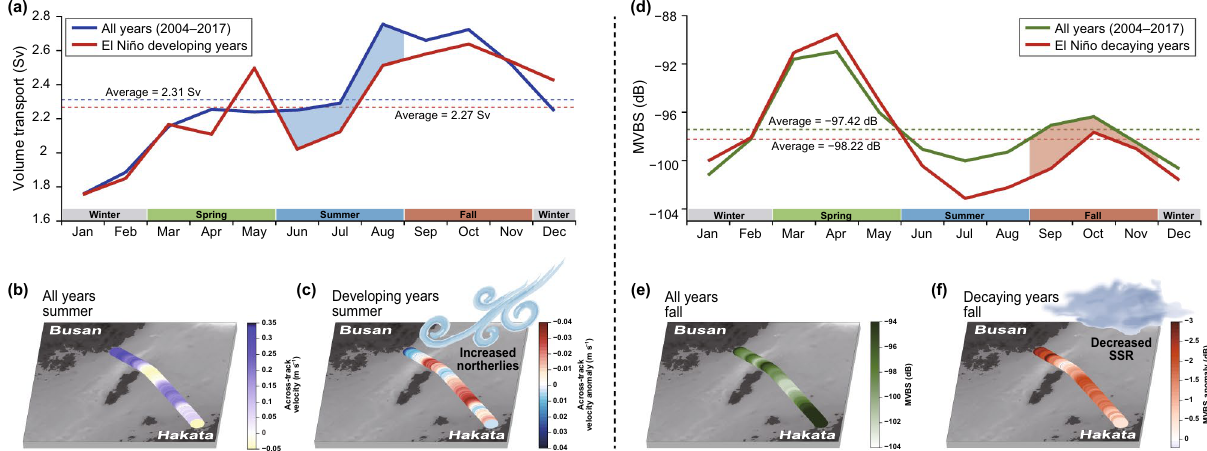
Figure 4. Climatic impact of El Niño on volume transport and the mean volume backscattering strength (MVBS) across the Korea/Tsushima Strait. ( a ) Monthly average of volume transport during all years and El Niño developing years (2009 and 2015). The shaded area indicates the difference in summer (JJA) volume transport between the two time windows. ( b ) Averaged summer across-track velocities during all years. ( c ) Averaged summer across-track velocity anomalies during El Niño developing years. ( d ) Monthly average MVBS during all years and El Niño decaying years (2010 and 2016). The shaded area indicates the difference in fall (SON) MVBS between the two time windows. ( e ) Averaged fall MVBS during all years and ( f ) Averaged fall MVBS anomalies during El Niño decaying years. The figure was created using MATLAB (ver. 9.9.0.1592791 (R2020b) Update 5). The bathymetry is based on the SRTM30_PLUS dataset (https:// topex. ucsd.